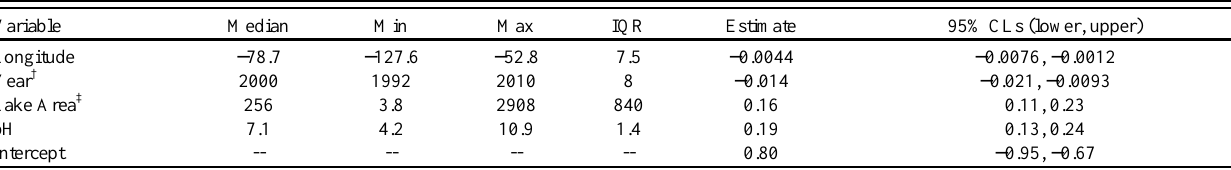
Table 2 . Descriptive statistics, interquartile range (IQR), and model-averaged parameter estimates (Estimate) and associated 95% confidence limits (95% CLs) for explanatory variables used to model patterns in Common Loon ( Gavia immer ) reproductive success across southern Canada between 1992 and 2010. Model-averaged parameter estimates and associated 95% CLs for longitude, year, log lake area, and intercept are based on the models in part one of the analysis (Table 1); for pH they are based on models in part two of the analysis (Table 3).